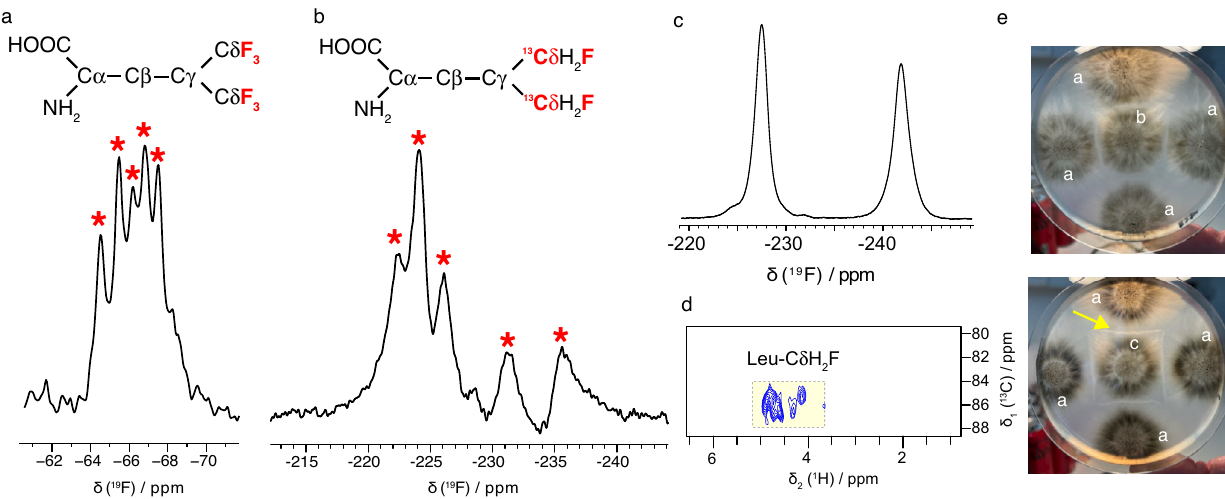
Fig. 3 Solid-state NMR analysis and prion infectivity of fl uorinated amyloid fi brils. 19 F NMR at 60 kHz MAS experiments of cell-free synthesized HET-s labeled with ( a ) 5,5,5,5 ’ ,5 ’ ,5 ’ -hexa- fl uoro-Leucine (CF-6F-HETs) and b 5,5 ’ -di fl uoro-L-leucine-5,5 ’ - 13 C (CF-2F-13C-HETs). c 19 F MAS NMR experiment recorded on 5,5 ’ -di fl uoro- L -leucine-5,5 ’ - 13 C. d 2D hCH experiment recorded on CF synthesized CF-2F-C-HETs. e Transfection of CF-synthesized and fl uorinated HET-s aggregates induces conversion of [Het-s*] strains to the [Het-s] prion-infected state. The central strain is the focal strain and is confronted four times with a [Het-S] tester (marked a). The upper plate is an example of a no protein control. The focal strain (marked b) retained the prion-free [Het-s*] state and leads to a diffuse contact line with the [Het-S] tester (no barrage). The lower plate is an example of a strain transfected with CF-synthesized fl uorinated HET-s. The focal strain (marked c) acquired the prion-infected [Het-s] state and produces a sharp contact line with the [Het-S] testers (barrage reaction, marked with yellow